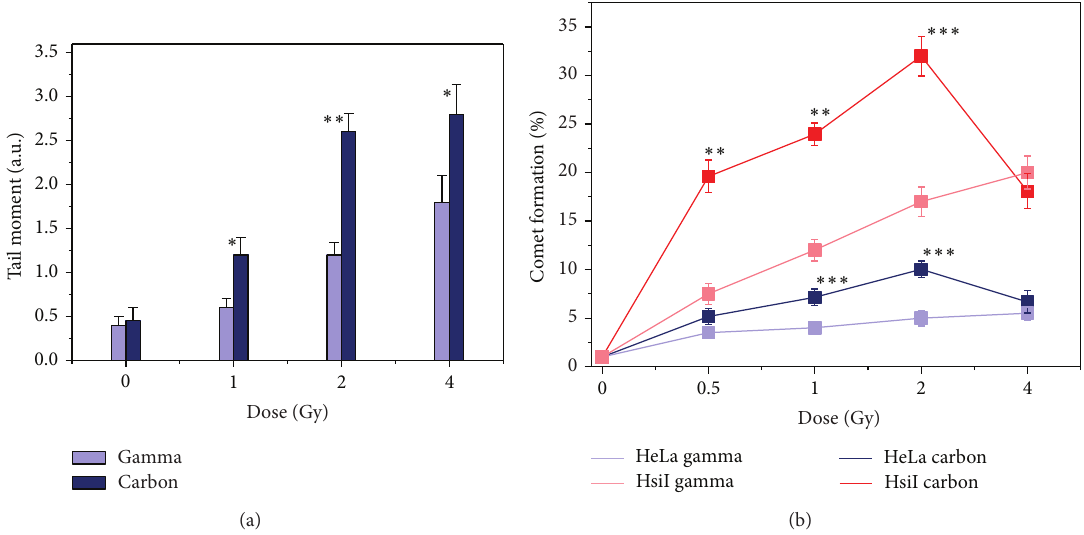
Figure 2: Comet Assay for DNA breaks detection after 24 h postirradiation of carbon ion beam and gamma radiation. (a) Tail moment was measured in HeLa cells after irradiation with carbon ion beam and gamma radiation at different doses (0–4 Gy). (b) % of comet formation in carbon ion beam and gamma irradiated each of both cells HeLa and HsiI at various doses (0–4 Gy). Statistical significance level was calculated within carbon ion beam and gamma irradiated groups of each cell type and denoted by 𝑃 values. “ ∗ ” means ( 0.01 < 𝑃 ≤ 0.05 ), “ ∗∗ ” means ( 0.001 < 𝑃 ≤ 0.01 ), and “ ∗ ∗ ∗ ” means ( 𝑃 ≤ 0.001 ).